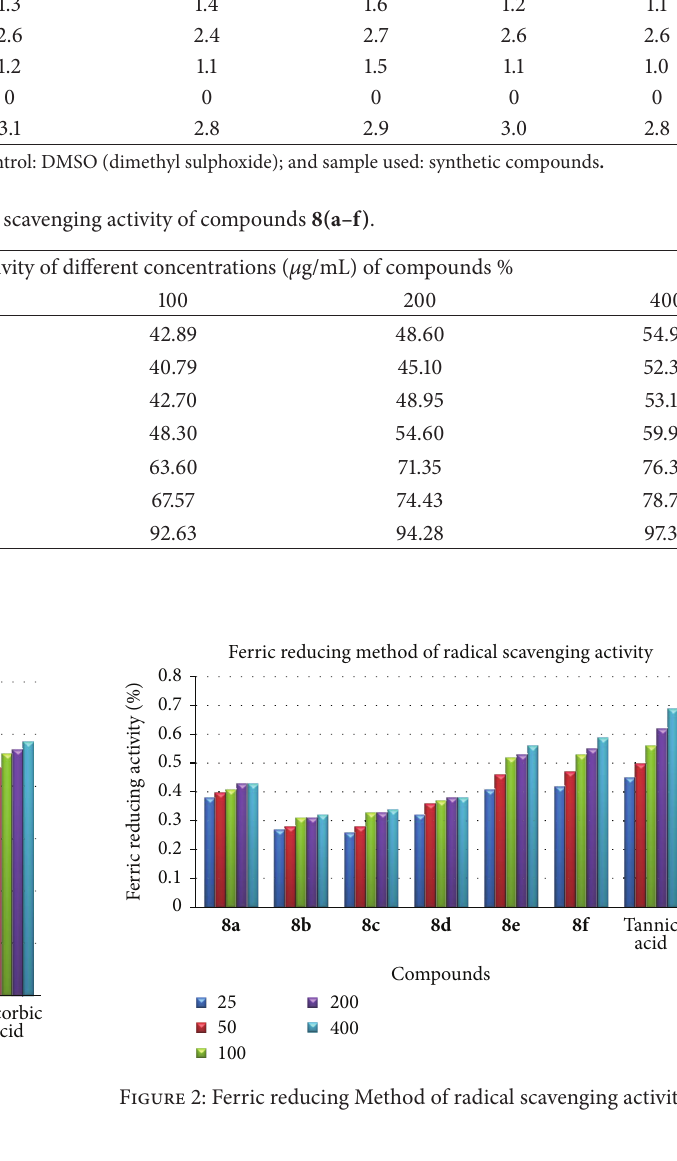
Figure 1: DPPH method of radical scavenging activity.